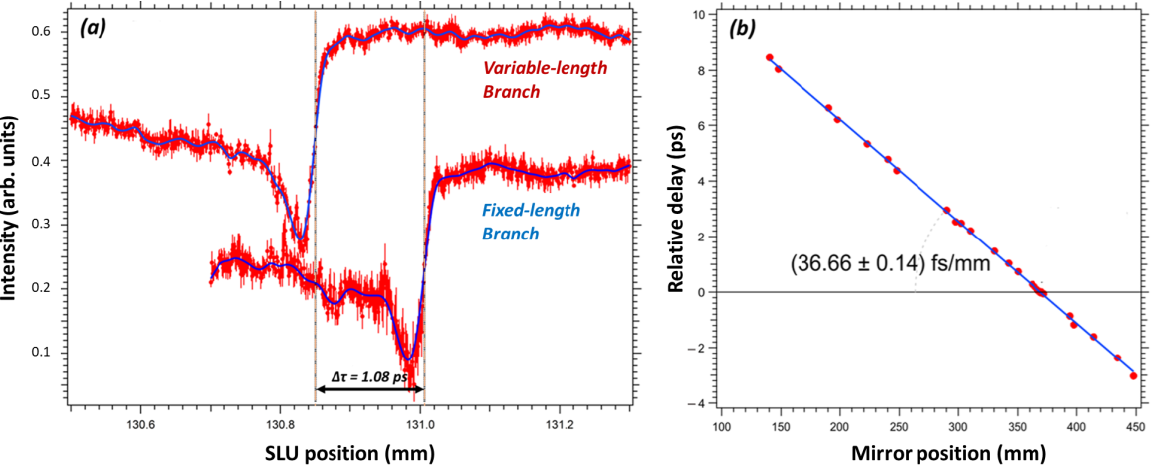
Figure 2. ( a ) Si 3 N 4 optical transient reflectivity measured by means of a FEL (pump) and a SLU (probe) pulses. The two time-traces refer to the data acquired using the FEL pump beam travelling through the fixed-length branch, as well as the variable-length one. These datasets refer to a delay between the two FEL pulses equal to ∆ τ = +1.08 ps. ( b ) Linear dependence of ∆ τ vs. the M6/M7 positions, used for the AC/DC calibration.